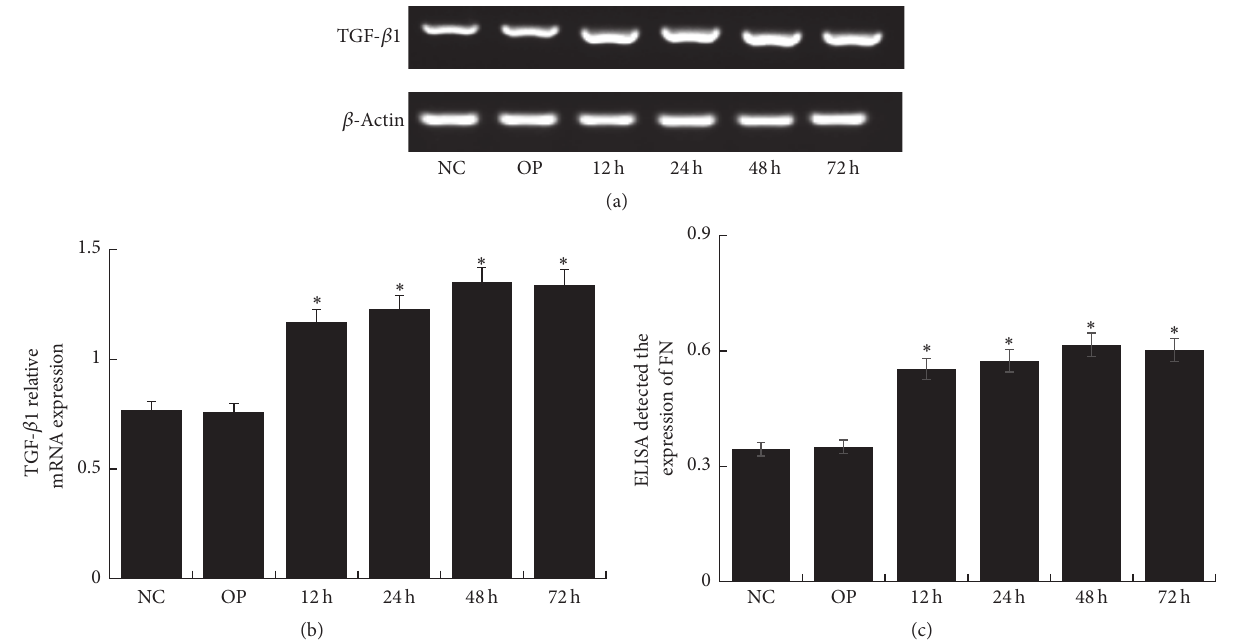
Figure 6: The expression of TGF- 𝛽 1 and FN in mesangial cells treated with 30mmol/L glucose for different time. (a) RT-PCR strip chart for different time. Compared with NC group, the expression of TGF- 𝛽 1 upregulated in HG group for different time, especially for 48 h. (b) The corresponding relative gray value statistics graph of the mRNA level. ∗ 𝑃 < 0.05 versus NC group. (c) FN ELISA kit detected the level of FN in supernatant of GMCs treated with 30 mmol/L glucose for different time. Compared with NC group, the expression of FN upregulated in HG group for different time, especially for 48 h; ∗ 𝑃 < 0.05 versus NC